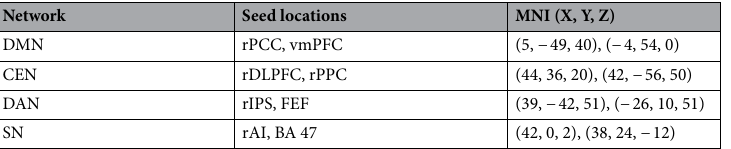
Table 3. ROI seed locations. All seed locations were selected using prior rsfMRI research that used WM as a behavioral correlate of